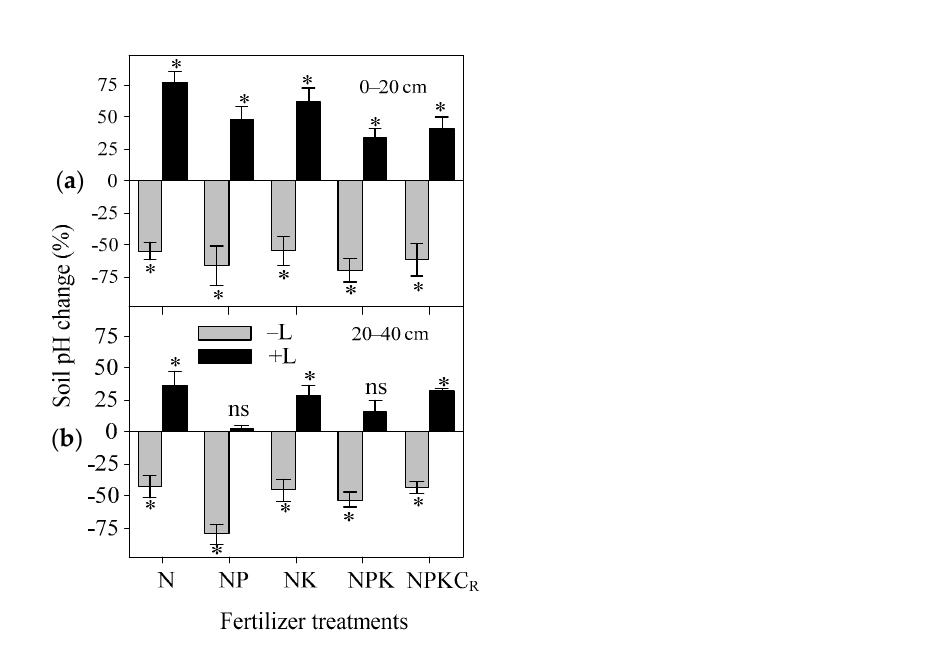
Figure 2. ( a ) Soil pH changes (%) between 2011 and 2018 for each fertilization treatment in − L and +L under 0–20 cm; and ( b ) under 20–40 cm soil depths, compared with soil pH in control ( C ) plot. Bars represent SD of means ( n = 4); *, denotes significantly increased or decreased soil pH of fertilizer treatments compared with control at p ≤ 0.05 with ns denoting p > 0.05 by LSD test. − L: without lime application, +L: with lime application.